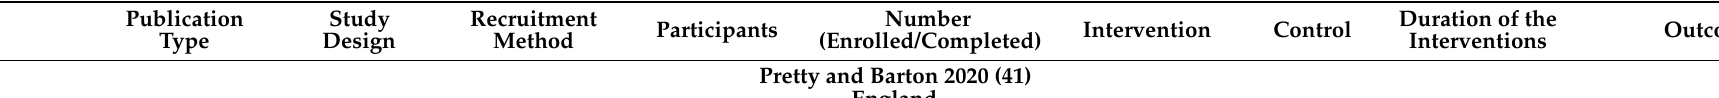
Table 2. Total data